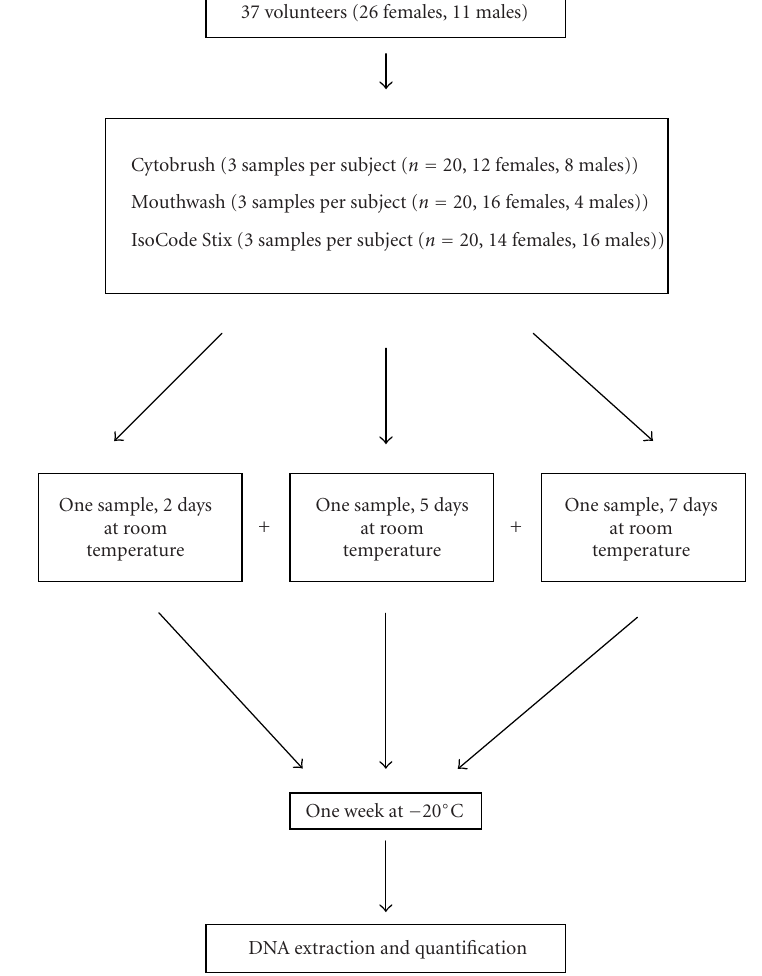
Figure 1. Diagram of sample processing. For each method of buccal cell collection, three samples were stored for 2, 5, or 7 days at room temperature to simulate the mail delay before one week at − 20 ◦ C and DNA